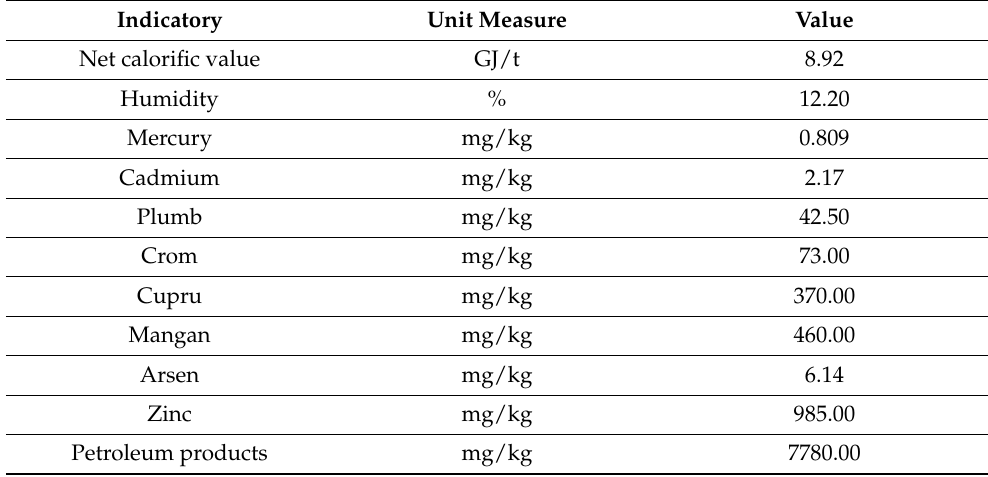
Table 1. Sewage sludge composition from a municipal waste treatment installation in